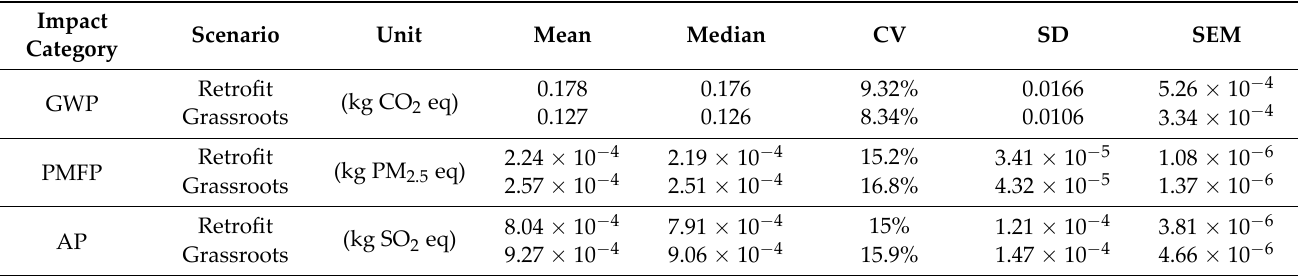
Table 10. Uncertainty analysis of two scenarios, method: ReCipe 2016 Midpoint (H), characterization at 95% confidence level.